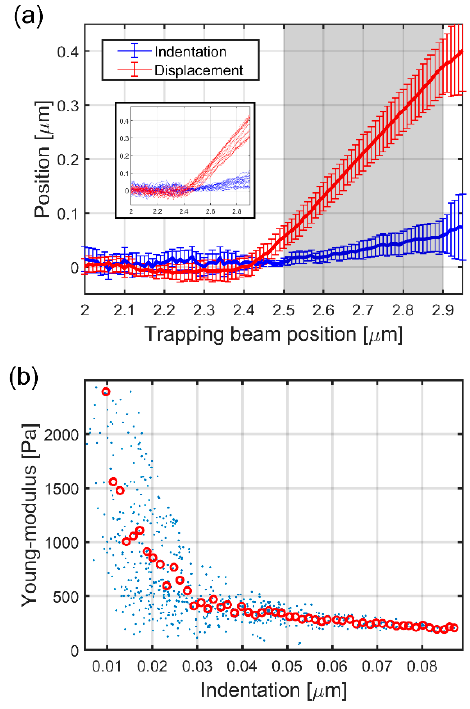
Figure 5. The measured indentation and displacement data and the Young’s modulus calculated from them. The indentation (blue line) and displacement (red line) data on panel ( a ) are calculated from the aligned traces of the 19 cell indentation experiments as shown in Figure 4b; the error bars represent standard deviation. The shaded area highlights the reliable range for the two quantities. The inset shows the individual displacement traces (red) and indentation traces (blue) calculated separately for the 19 experiments. The Young’s modulus as the function of indentation over the values highlighted in ( a ) is shown in panel ( b ). The blue dots represent all of the approximately 800 individual point pairs (40 trap positions × 19 experiments), while the red circles are their averages in 60 regions over the 0–0.09 μ m indentation range.